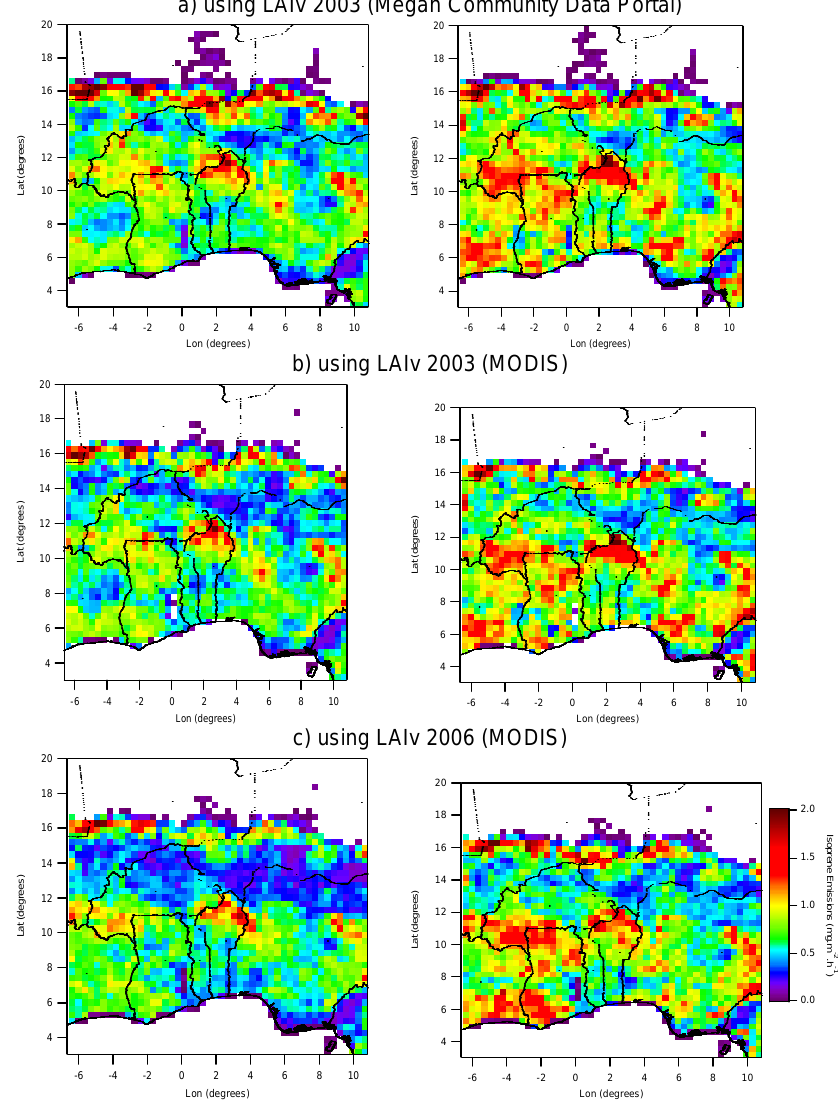
Fig. 4. Isoprene emissions (mgm − 2 h − 1 ) estimated by MEGAN (domain WA1) using three LAI fields from two different sources, LAI MCDP (a) , LAI MODIS 2003 (b) LAI MODIS 2006 (c) and obtained by M¨uller et al., 2007, for the year 2006 (d) , and isoprene con- centrations (ppt) measured below 700m (e) . These are monthly averages and the data from the current study are calculated from 3 hourly